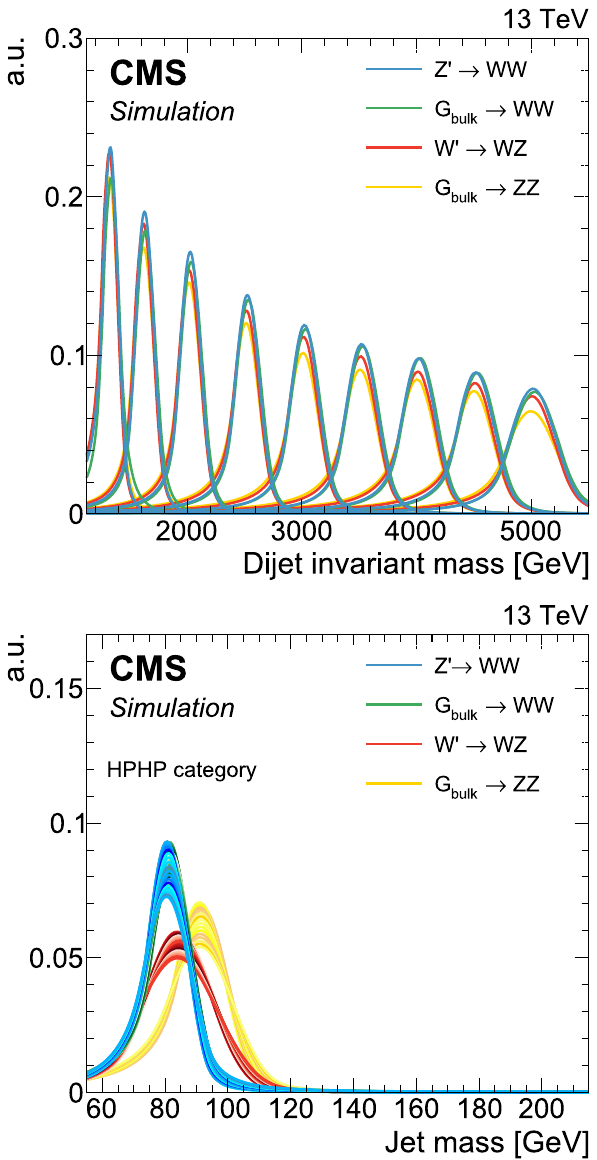
Fig. 7 The final m jj (upper) and m jet1 (lower) signal shapes extracted from the parameterization of the dCB function. The same m jj shapes are used for both purity categories. The jet mass distributions are shown for a range of resonance masses between 1.2 and 5.2TeV for one of the two jets in the events in the HPHP category. Because the jets are labelled randomly, the jet mass distributions for the second jet are essentially the same as the one shown. The distributions for a G bulk decaying to WW have the same shapes as those for the Z (cid:3) signal and are